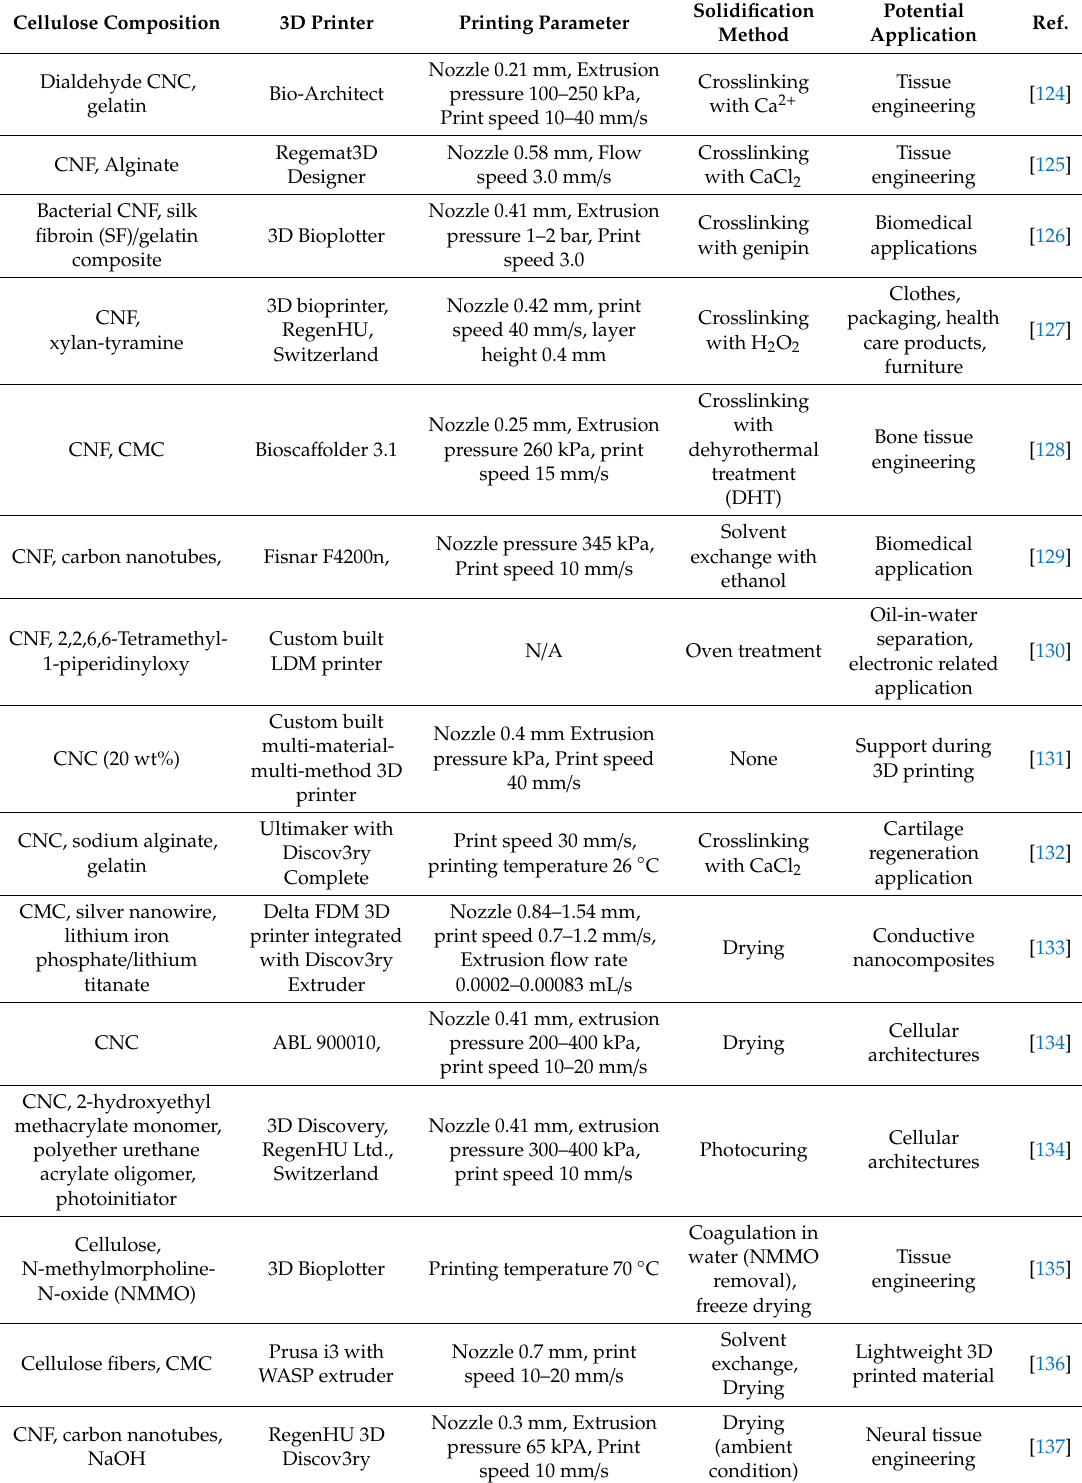
Table 5. Review of cellulose matrix as 3D printing hydrogel using LDM technique. Cellulose